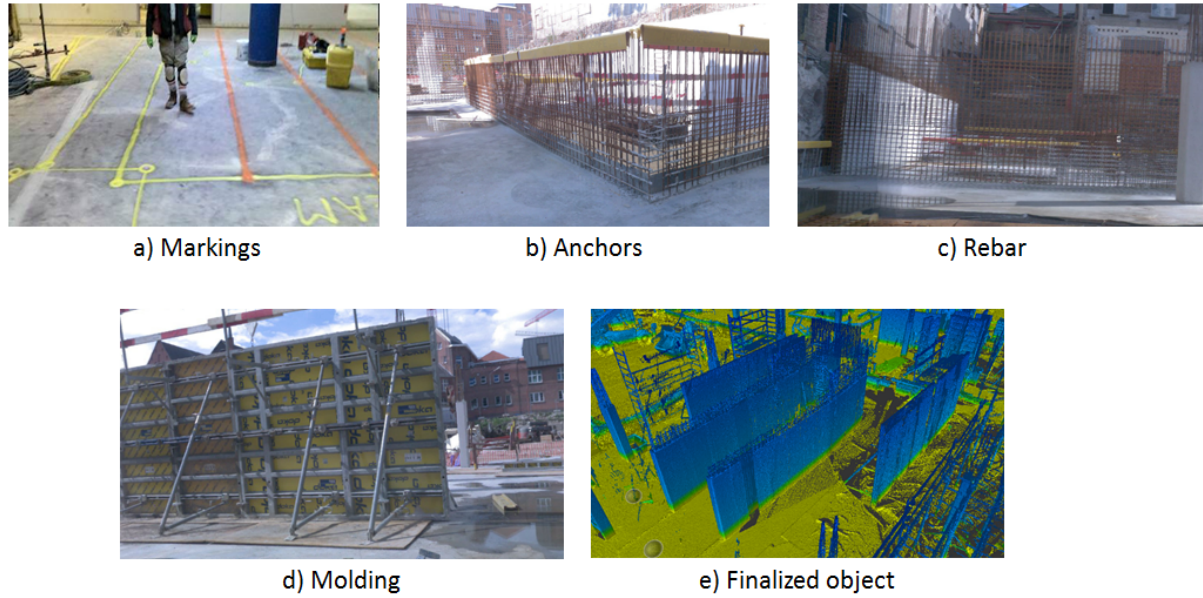
Figure 1: The phases of the Percentage of Completion (PoC) of in-situ cast concrete